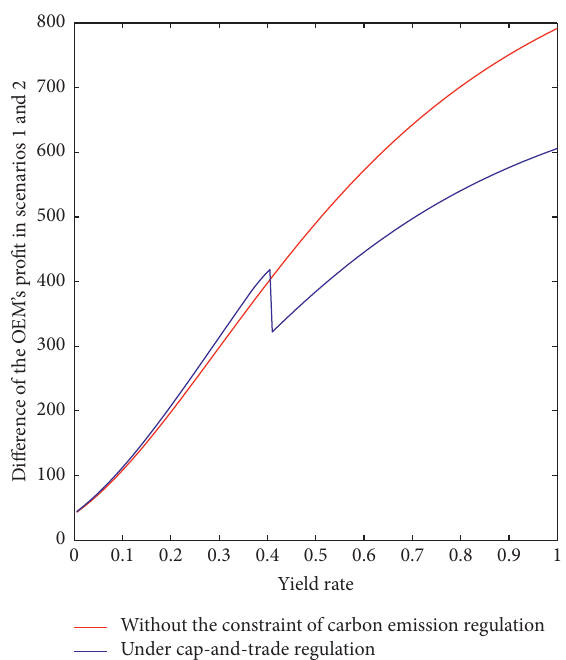
Figure 1: Difference in the OEM’s profit before and after the TPR enters vs. yield